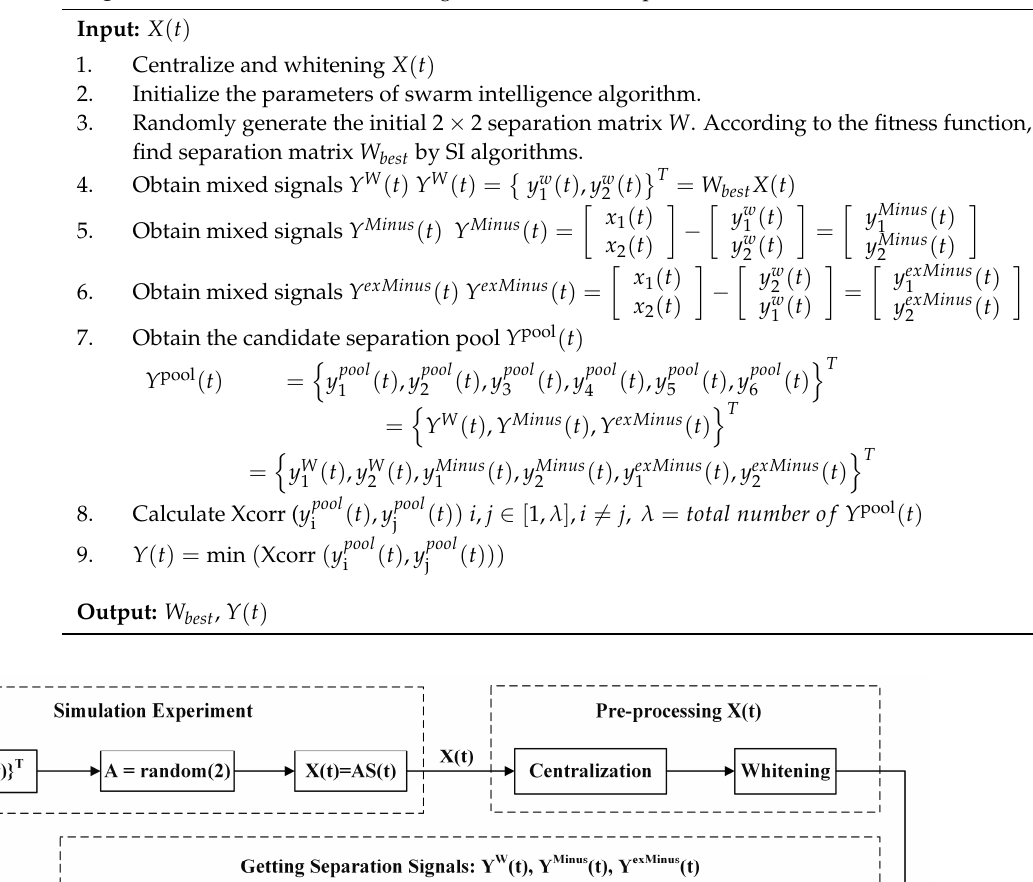
Algorithm 2 : SI-XBSS (Swarm Intelligent Blind Source Separation based on Cross-Correlation)